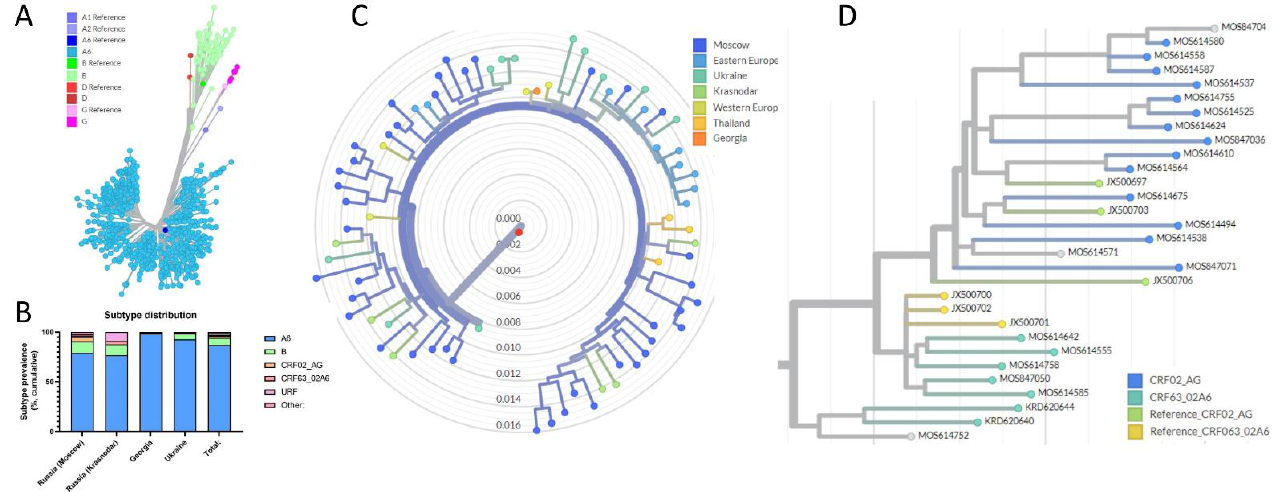
Figure 1. Sequence analysis of the HIV-1 pol gene. ( A ): Unrooted phylogenetic analysis. Colours were assigned based on sequence analysis using HIV COMET, the Stanford database tool, and the REGA